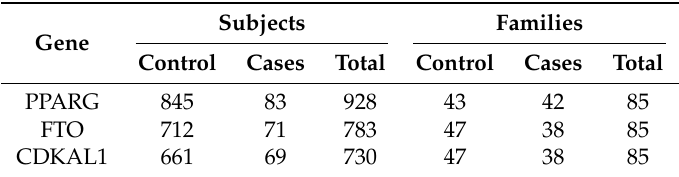
Table 2. Summary of cases per subjects and